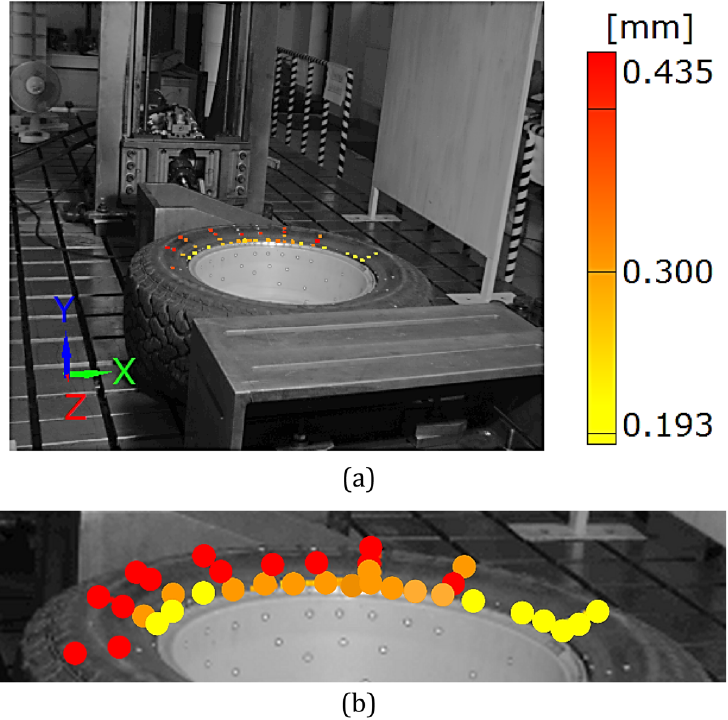
Figure 16. Distribution of the resultant vectors of deflection for the SUV tire after unloading: ( a ) general view, ( b ) magnified view of the